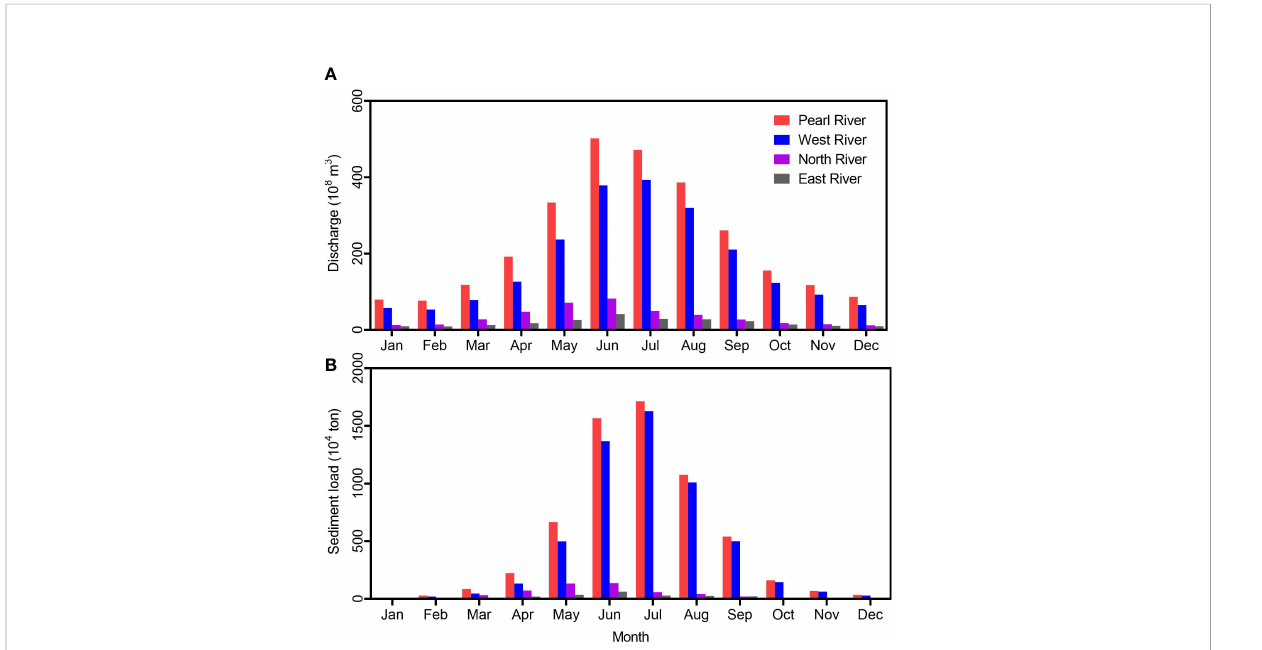
FIGURE 6 Multi-year averages of monthly distribution of discharge (A) and sediment load (B) in the Pearl River as well as its major tributaries from the 1950s to the